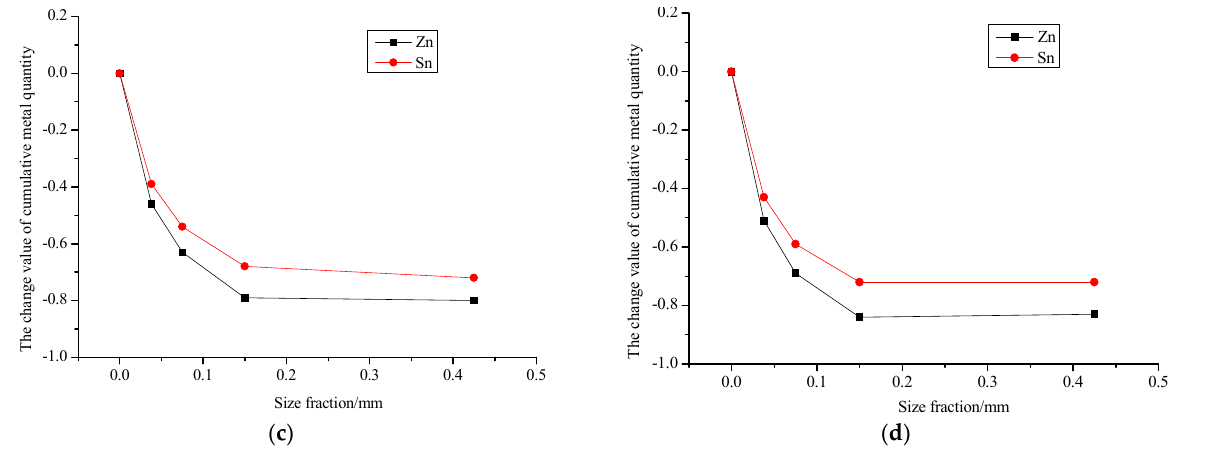
Figure 8. Change in the cumulative quantities of metal for various size fractions for different grinding times when the mill speed was 12.8 r/min. ( a ) Grinding time is 10 min. ( b ) Grinding time is 20 min. ( c ) Grinding time is 30 min. ( d ) Grinding time is 40 min. Table 9. Changes in the cumulative quantities of metal for different grinding times when the mill speed is 12.8 r/min.